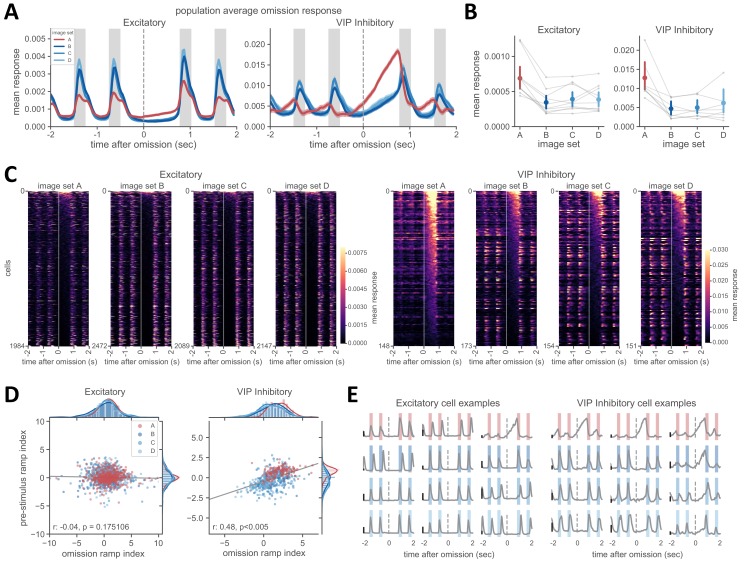
VIP cells show strong ramping activity during stimulus omission.(A) Average population activity around the time of stimulus omission. On average, excitatory neurons have little change in activity following stimulus omission (left panel). In contrast, activity of the VIP population for the familiar image set A continues to ramp up until the time of the next stimulus presentation. In sessions with novel images (image sets B, C, D), the VIP population also shows some change in activity following stimulus omission, but to a lesser degree than with familiar images. (B) Mean activity following stimulus omission is higher during sessions with the familiar image set A. The mean response in a 750 ms window following the time of stimulus omission was first computed for each cell in a given session, then averaged across cells in that session. Connected gray points indicate sessions recorded in a given mouse. Colored points represent the average across sessions for each image set ± 95% confidence intervals. p<0.008 for all comparisons with image set A, except A-C in VIP inhibitory cells (Welch’s t-test used for all statistical comparisons, see Materials and methods for additional details). (C) Heatmap of activity around the time of stimulus omission across all excitatory (left panels) and VIP inhibitory cells (right panels), sorted by magnitude of activity in the omission window. Start of omission period is shown by white vertical line at time = 0 and extends to 750 ms thereafter when the next stimulus is presented. (D) The strength of the omission ramp index (y-axis) and pre-stimulus ramp index (x-axis) are positively correlated across VIP cells, but not excitatory cells, indicating that VIP cells with pre-stimulus activity typically also show ramping during stimulus omission. Data points across all image sets for each panel were fit with linear least-squares regression. Correlation and significance values for the fit are shown in lower left of each panel. (E) Example cells showing different response dynamics during stimulus (colored bars) and omission (time of expected stimulus indicated as gray dashed line) for excitatory and VIP inhibitory cells. Color of shaded bars indicates image set (familiar images in red, novel images in blue). Cells typically show either stimulus-evoked activity and no omission response, or pre-stimulus ramping and strong omission responses. Some cells (examples in right column of right panel) show a combination of stimulus-evoked and omission activity. Scale bar indicates a response of 0.01.